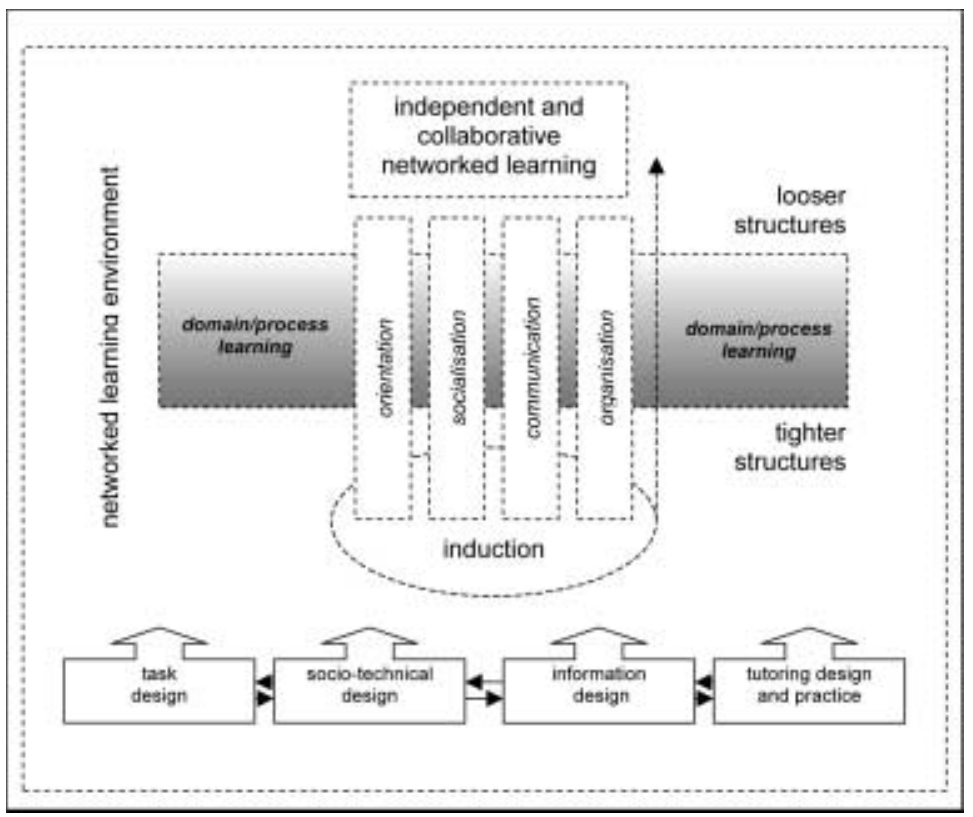
Figure 2. Non-linear framework for process support in networked